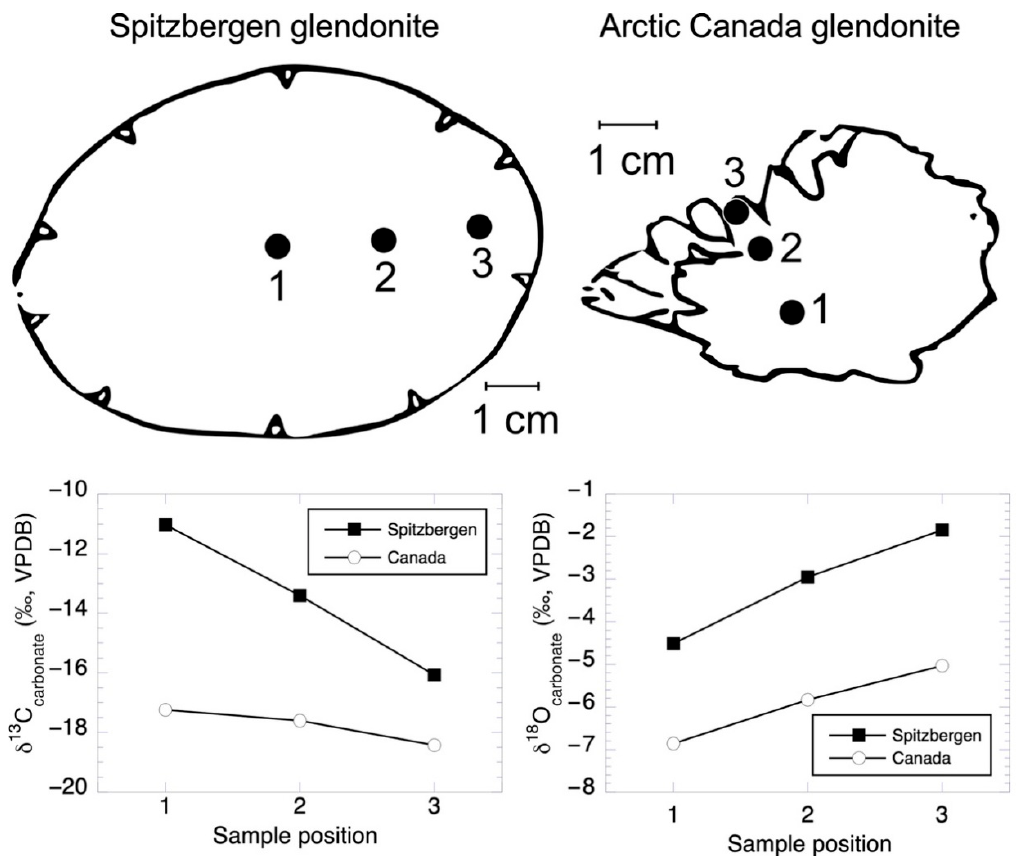
Figure 9. Carbon and oxygen isotope measurement traverse across glendonite pseudomorphs of ikaite from Spitzbergen and Canada. Changes in δ 13 C glendonite likely reflect diagenetic changes in δ 13 C DIC of the DIC pool during growth of original ikaite. The changes in δ 18 O glendonite are possible due to kinetic isotope effects during transformation or resetting of oxygen isotope composition during recrystallization of ikaite to calcite.